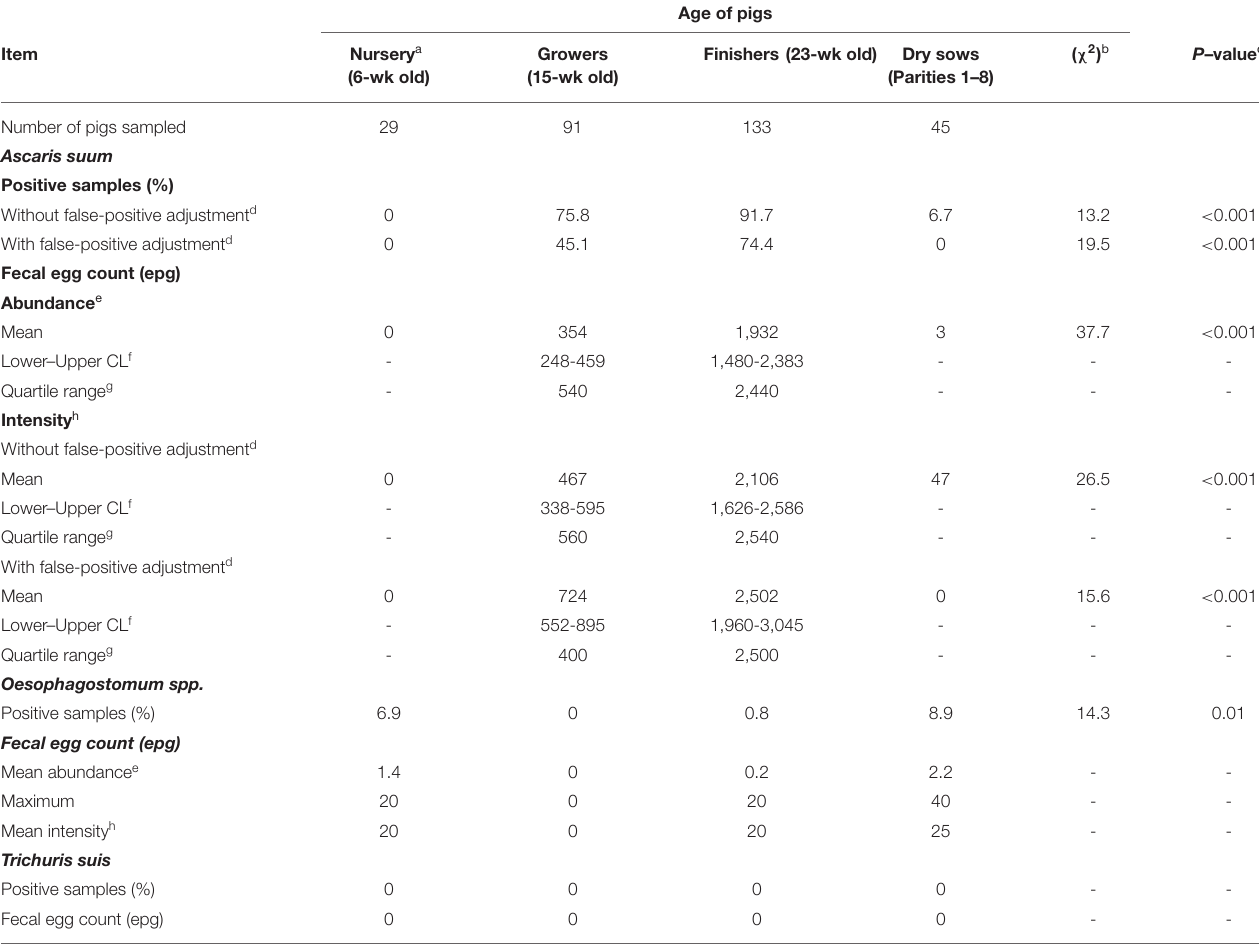
TABLE 1 | Positive samples and fecal egg counts, measured in eggs per gram (epg), of intestinal parasites in pigs at different